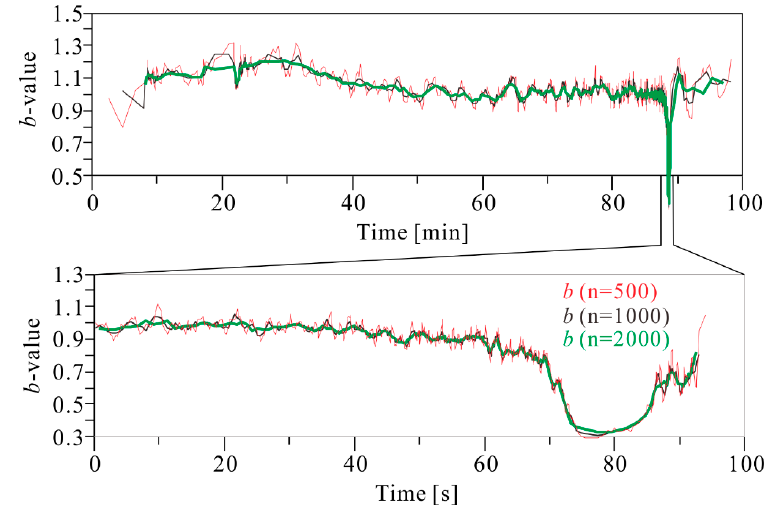
Figure 2. Seismic b -value estimated using the maximum likelihood method for a running window of n events with a step of n /4 events.